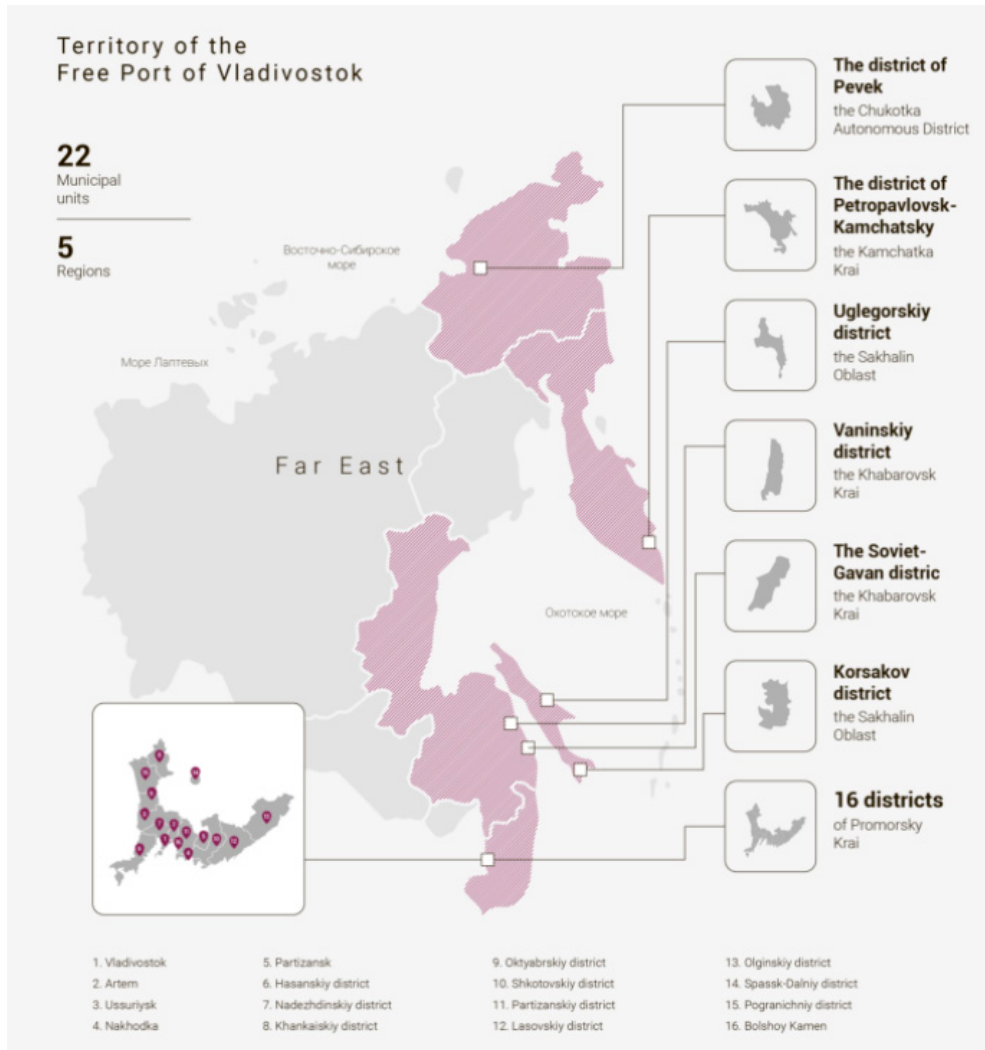
Figure 1. Territory of the free port of Vladivostok. Source: official site of Far East Development Corporation. https://erdc.ru/en/about-spv/ (accessed on 21 January 2021).